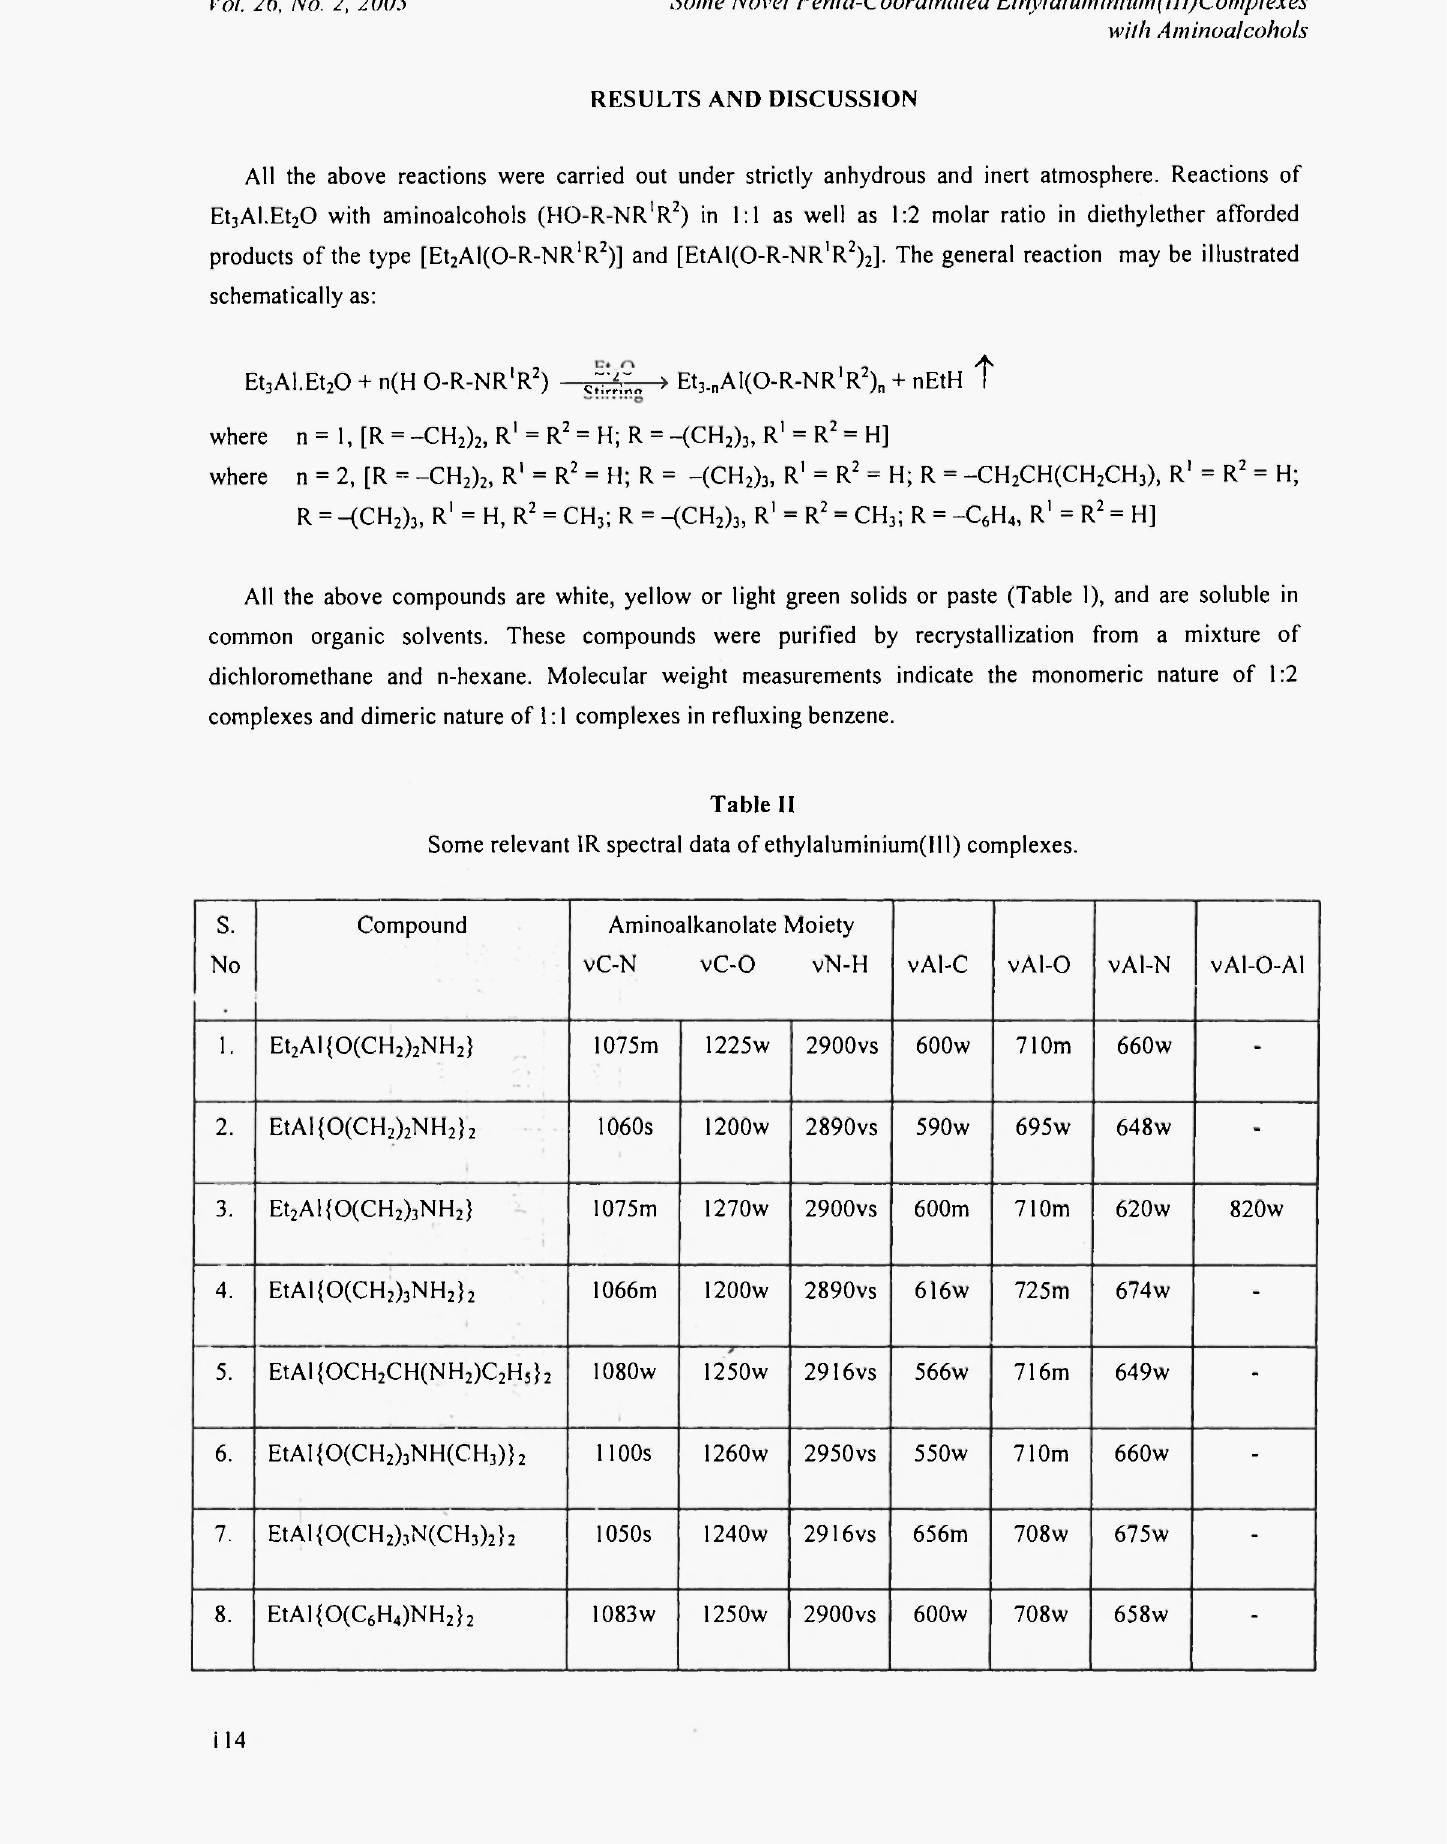
Some relevant 1R spectral data of ethylaluminium(lll)